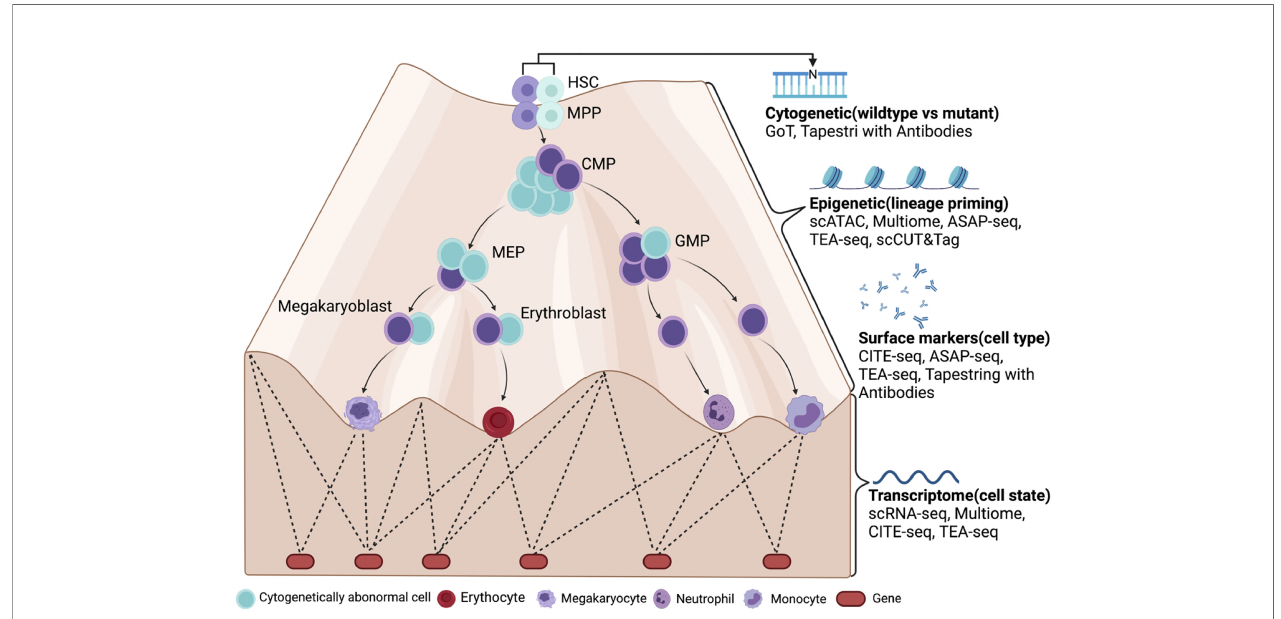
FIGURE 1 | A future look of MDS at single-cell resolution with multiomic tools (LR-MDS as an example). Cytogenetically abnormal cells can be distinguished from normal cells by single-cell mutation pro fi ling (cDNA or DNA) in MDS. Their differentiation stage and state are then de fi ned by their surface marker expression and transcriptome. With the help from chromatin accessibility assays such as scATAC-seq, the epigenetic landscape is revealed by transcriptome and gene regulatory networks, which determines the most subtle change in lineage priming process. Figure was created with